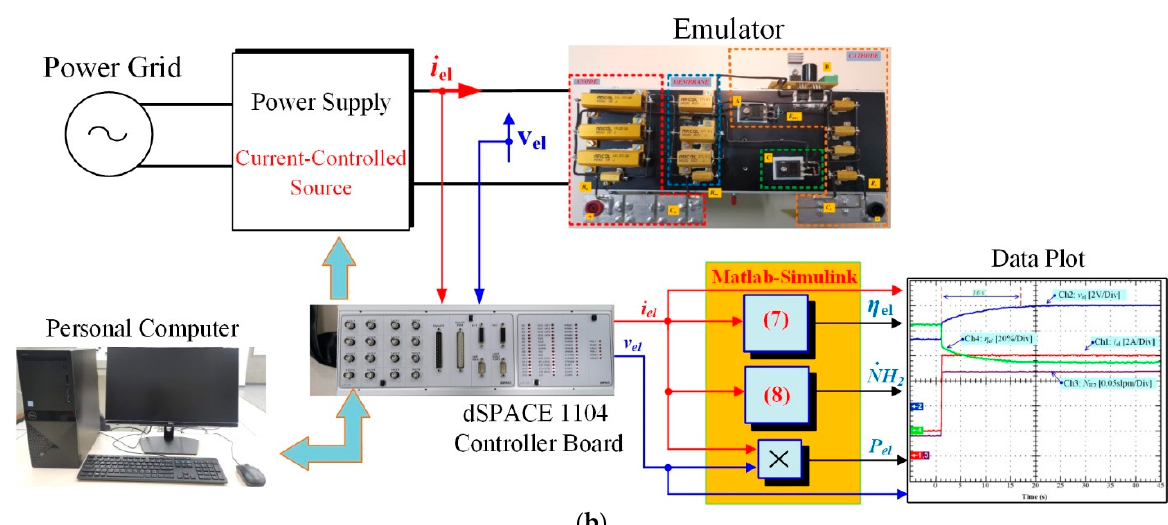
Figure 10. ( a ). Block diagram of the test rig to acquire data by the electrolyzer. ( b ). Block diagram of the test rig to test the emulator.